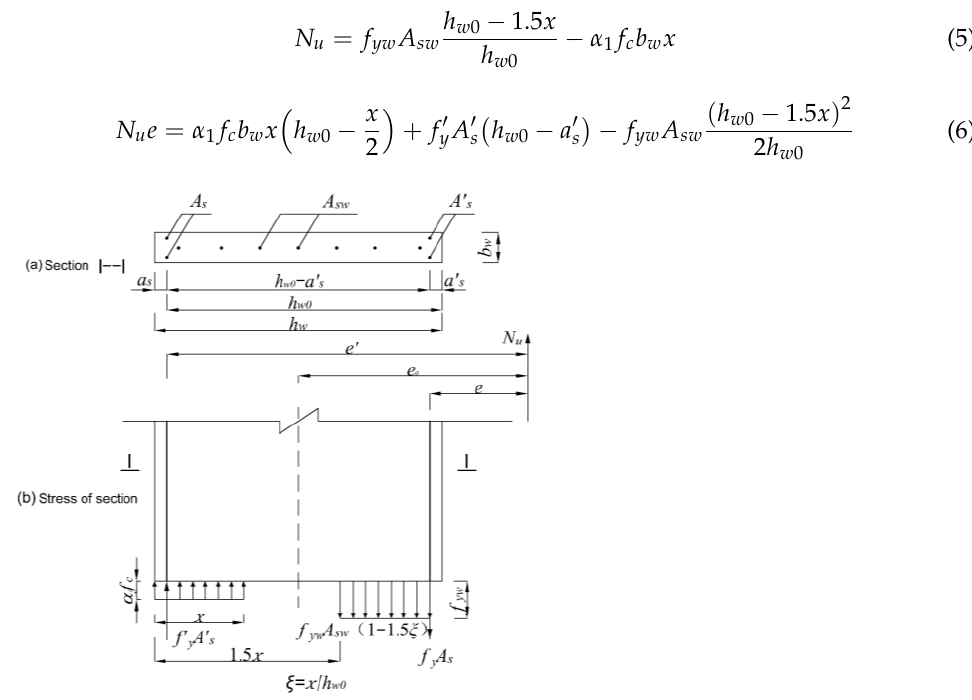
Figure 18. Calculating diagram of large eccentricity tension.